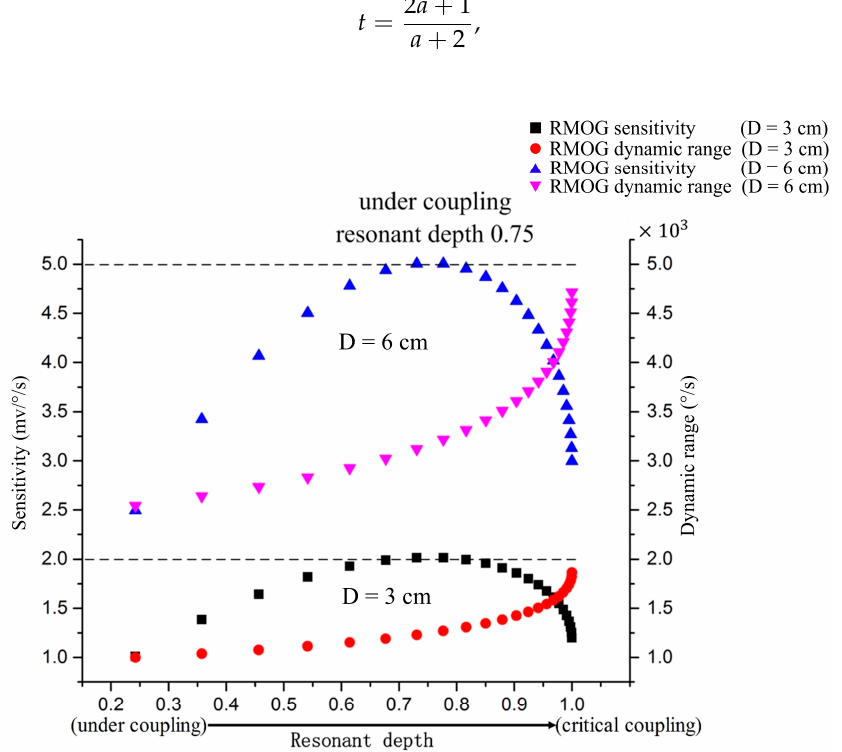
Figure 2. Gyroscope sensitivity and dynamic range as functions of resonant depth (as the coupling state varies from under-coupling to critical coupling).